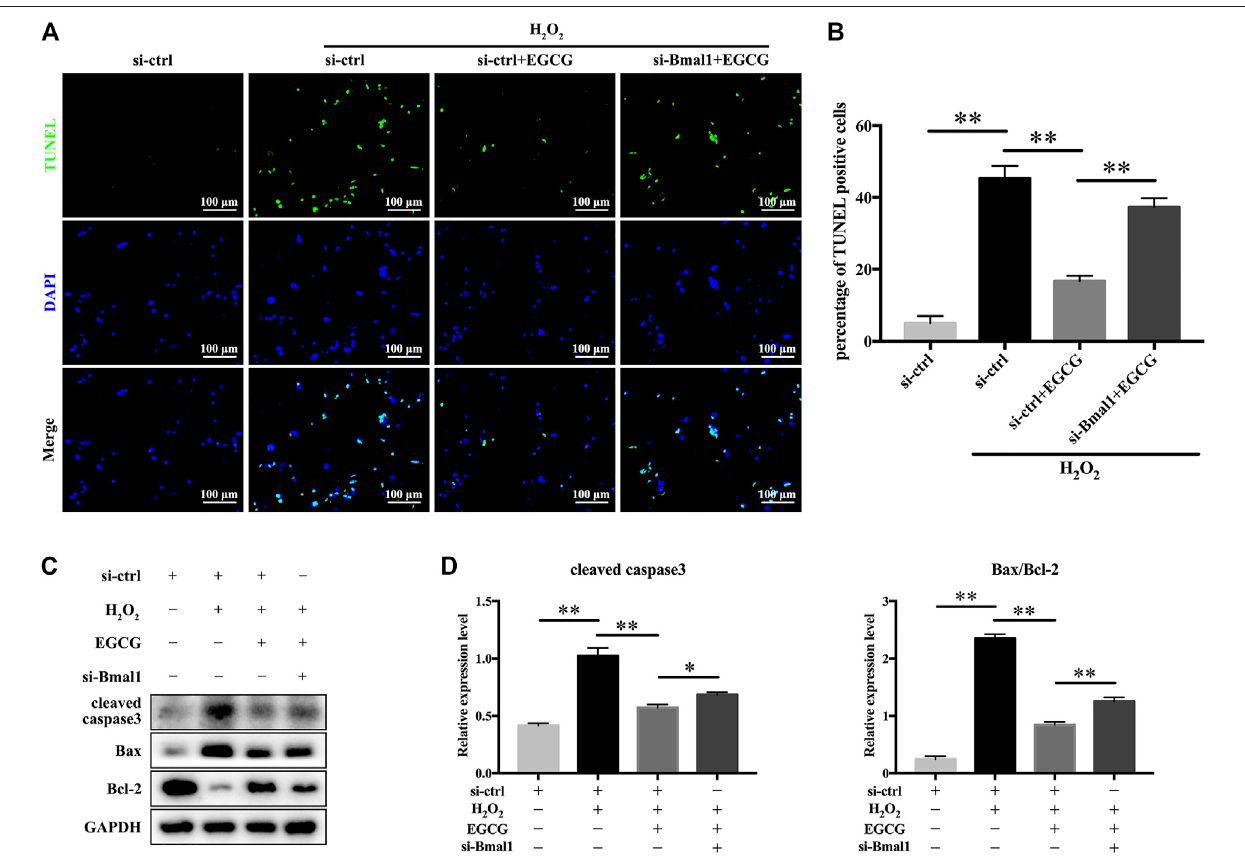
FIGURE 6 | EGCG attenuates H 2 O 2 -induced apoptosis in a Bmal1-dependent manner in rat NPCs. Rat NPCs were transfected with si-Bmal1 or si-ctrl for 48 h, followed by pretreatment with or without 20 μ M EGCG for 4 h and with H 2 O 2 for an additional 24 h. (A) Apoptosis of NPCs in each treatment group was examined by TUNEL assay, and (B) the TUNEL-positive cells were quanti fi ed. (C) Cleaved caspase3, Bax as well as Bcl-2 levels were measured by western blot analysis. (D) Quanti fi cation of the blots. Data are shown as the mean ± SD ( n (cid:2) 3). * p < 0.05, ** p < 0.01.